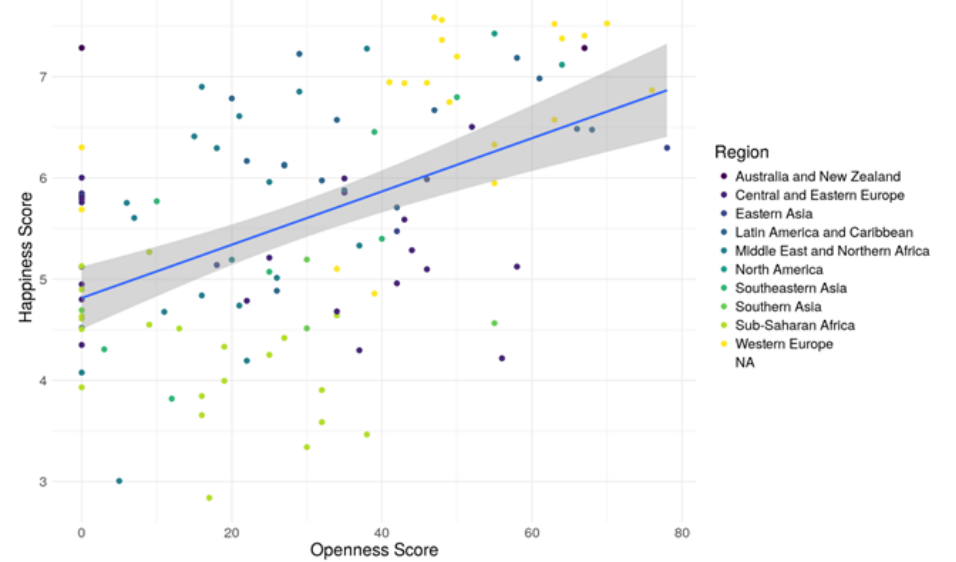
Figure 6. Openness and social happiness clustering and correlation in different regions.